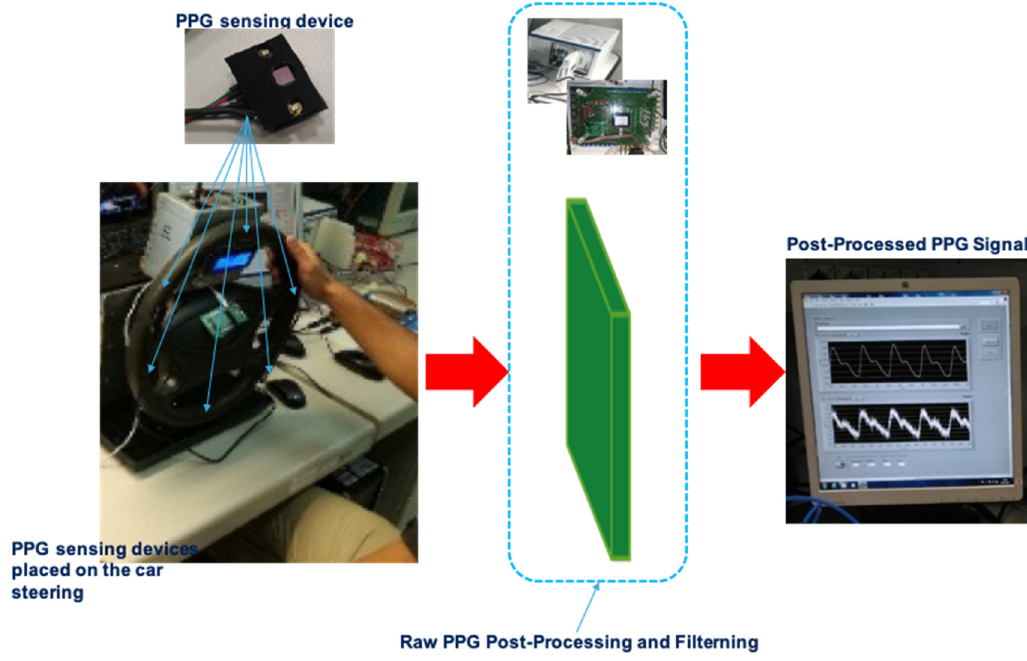
Figure 5. The automotive body hardware setup for collecting the PPG signal of the car driver.